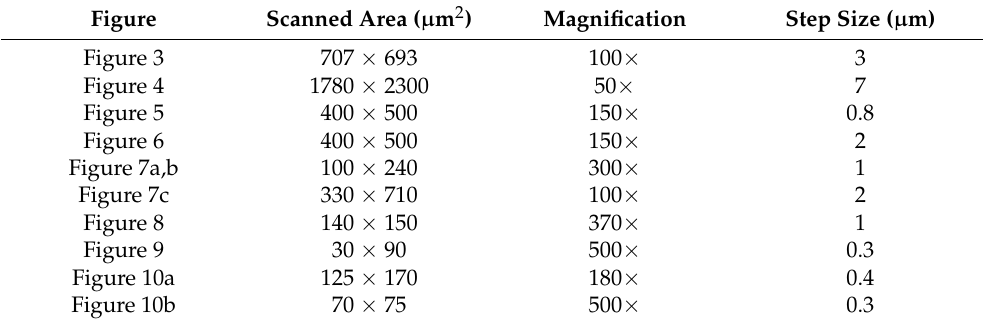
Table 2. List of settings (scanned area, magnification, step size) used for the collection of the relevant EBSD